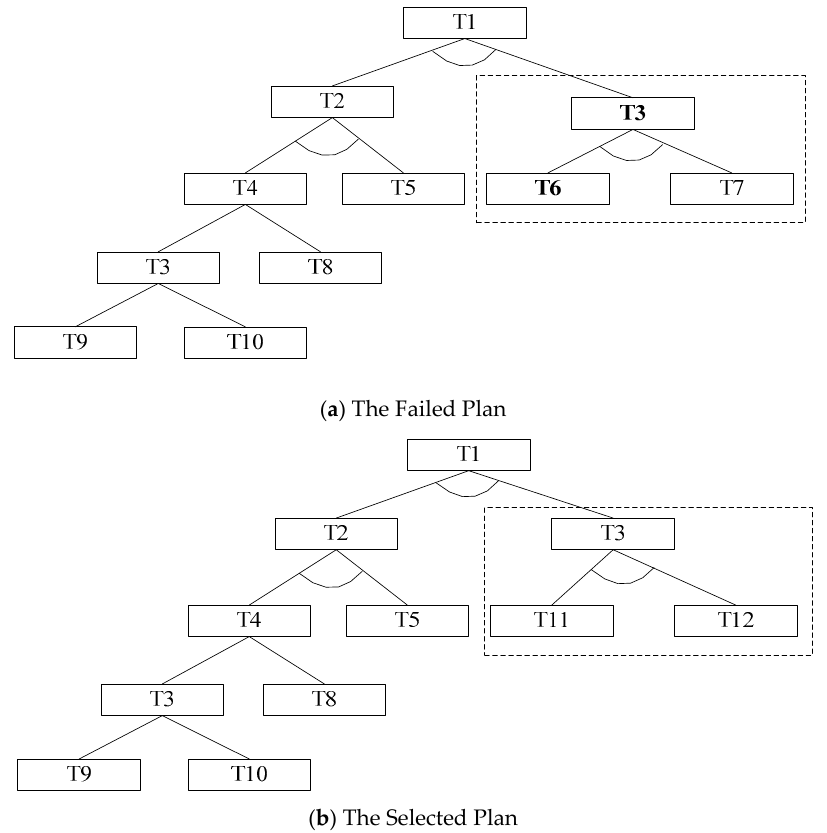
Figure 4. An Example of repairing a failed plan ( a ) owing to the failure of subtask T6 by employing an alternative plan ( b ).